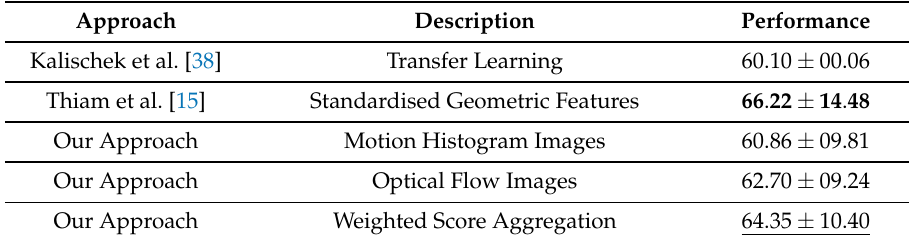
Table 4. Classification performance comparison to early works on the SenseEmotion Database in a LOSO cross-validation setting for the classification task T 0 vs . T 3